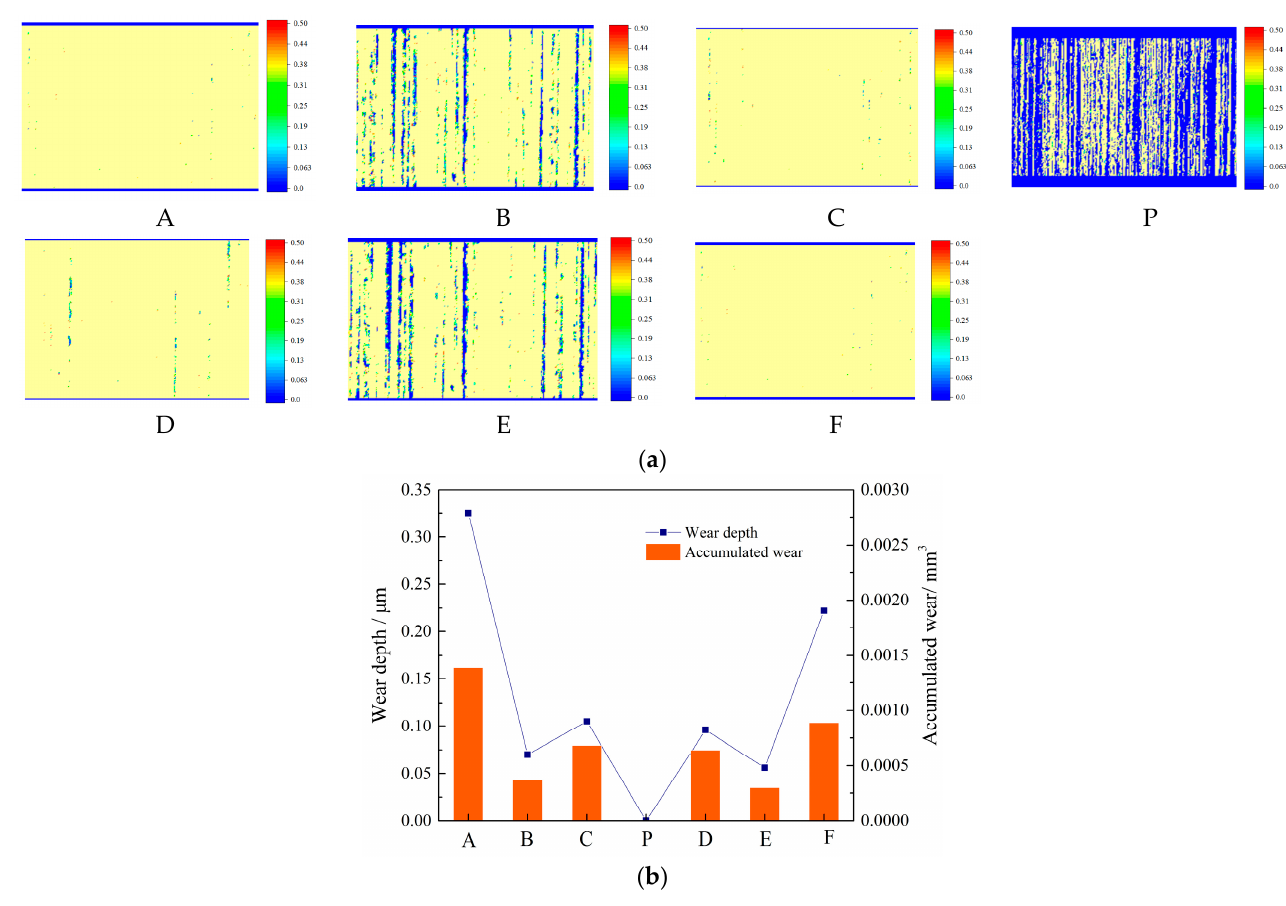
Figure 7. Tooth surface wear distribution and wear depth. ( a ) Wear distribution at different meshing points. ( b ) Wear depth and accumulated wear.